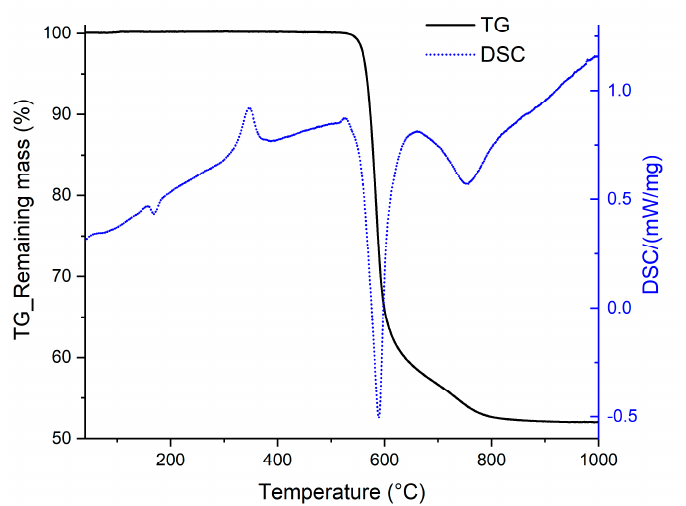
Figure 3. Thermogravimetric (TG) and differential scanning calorimetry DSC plot for PEEK with a heating rate of 10 °C/min under nitrogen atmosphere.